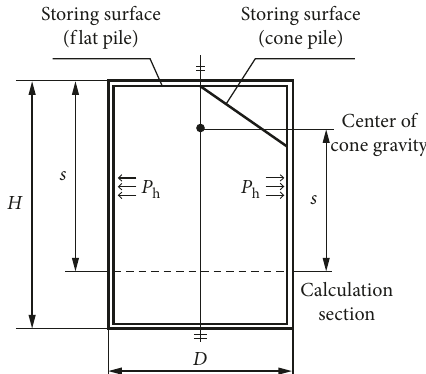
Figure 1: Mechanical model of silo wall pressure (no-funnel) (modified from Sun et al.